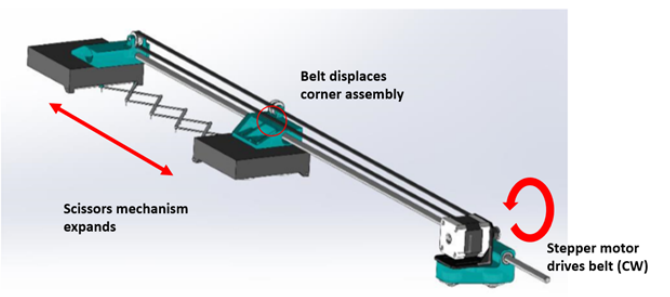
Figure 4. A quarter-view of the stretch tool detailing the movement of one scissor-hinge mechanism. During